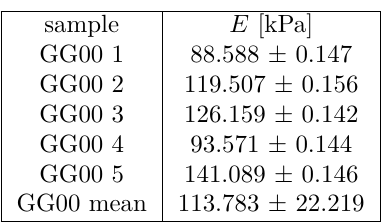
Table 1. Elastic properties of plain GG samples for